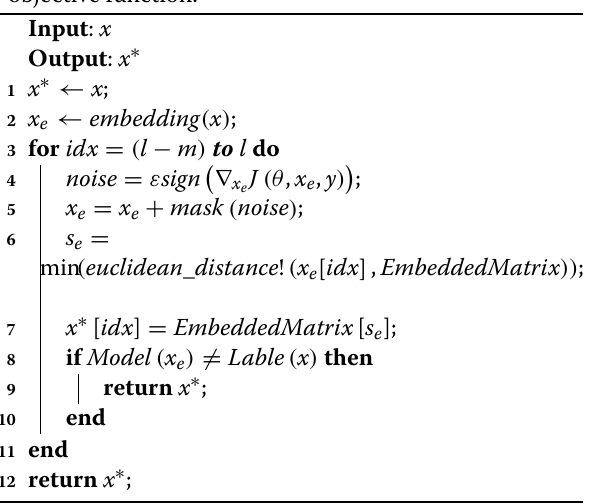
Algorithm 1: System-call Adversarial Sequence Generation